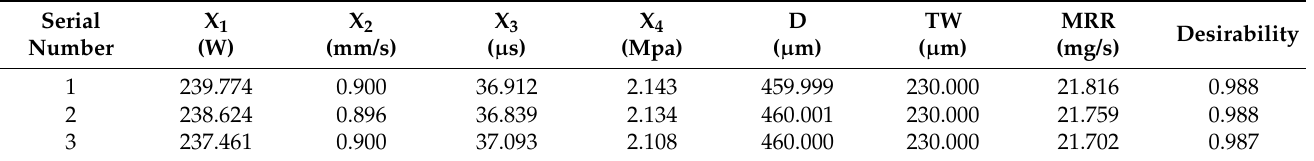
Table 11. Process parameter optimization scheme.